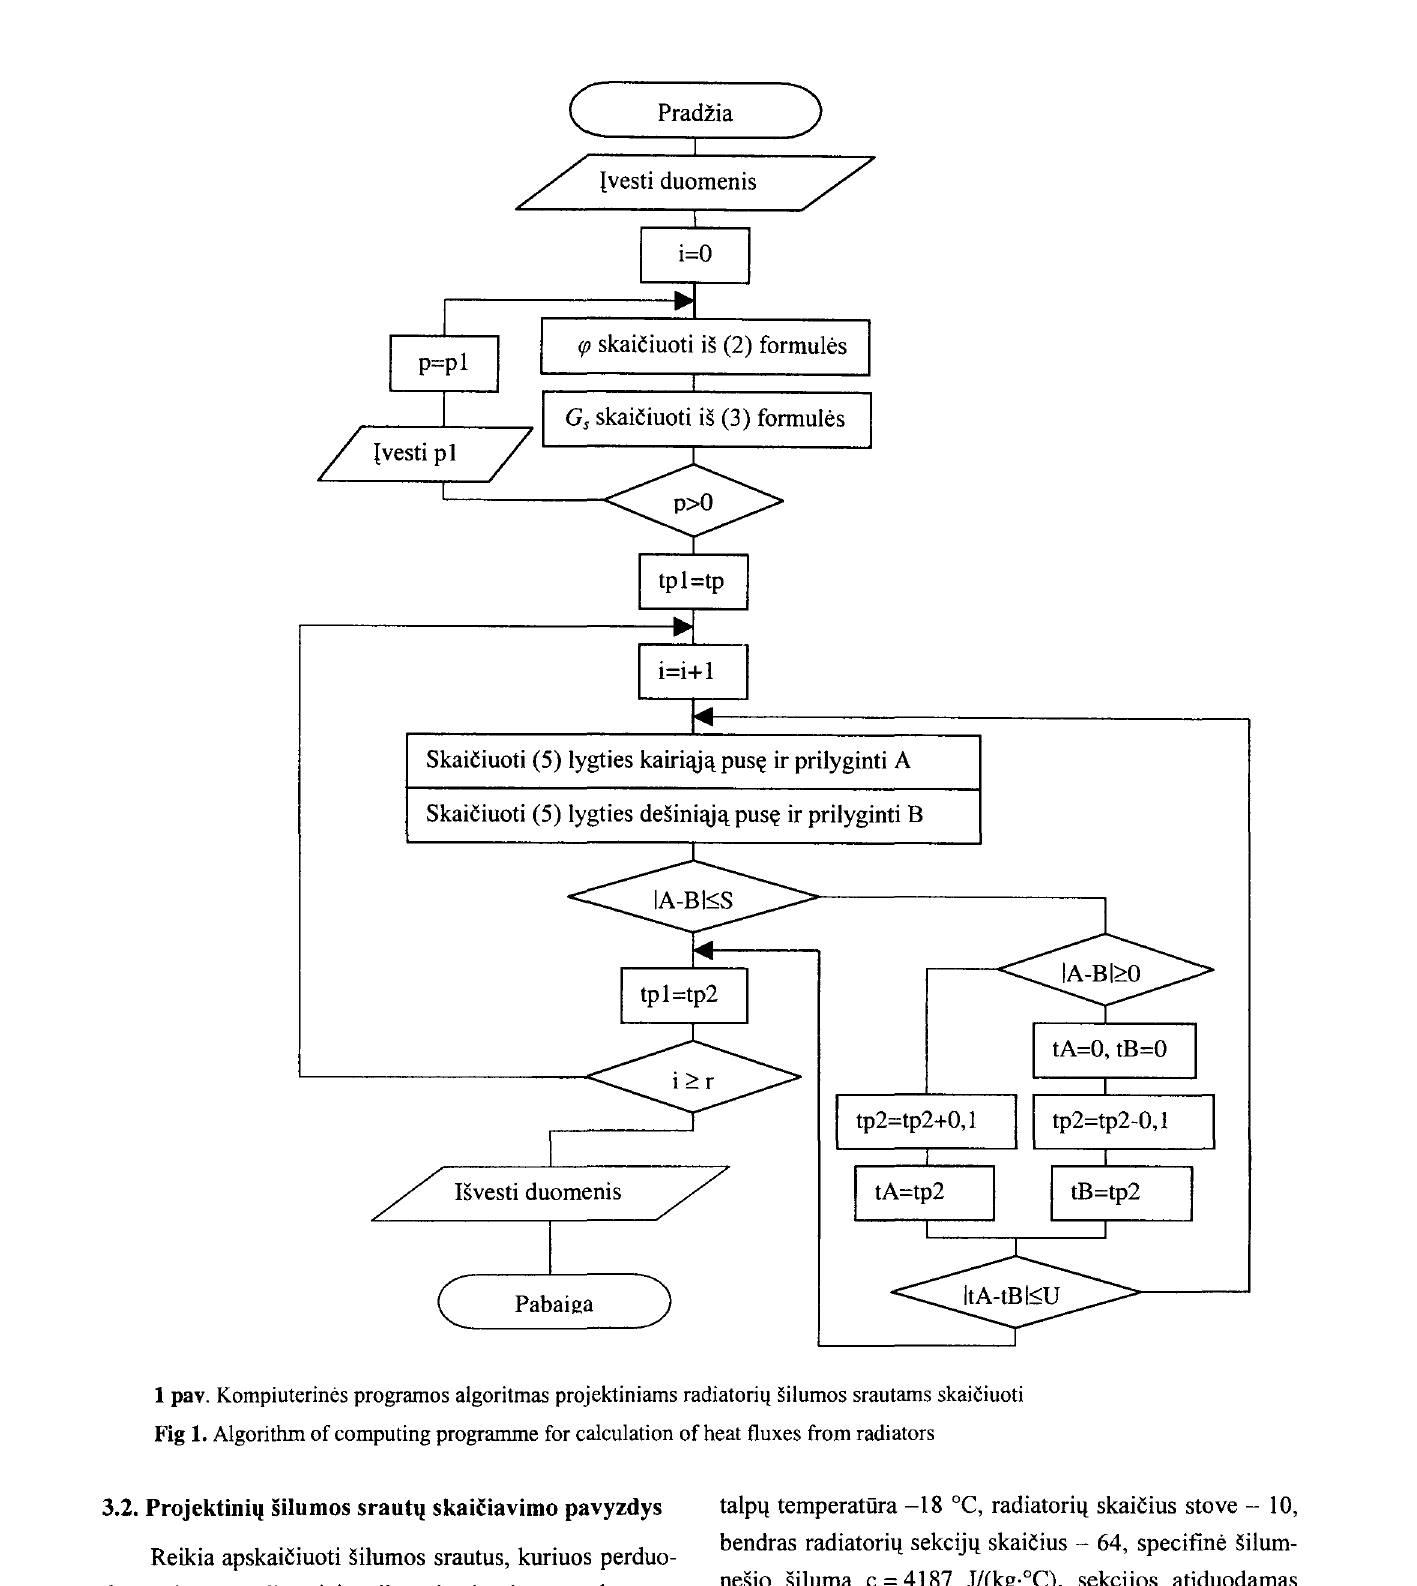
Fig 1. Algorithm of computing programme for calculation of heat fluxes from radiators 3.2. Projektiniq silumos srautq skaiciavimo pavyzdys Reikia apskaiciuoti silumos srautus, kuriuos perduo da patalpoms radiatoriai, prijungti prie vienvamzdes apa tinio paskirstymo sildymo sistemos stovo, kurio schema pateikta 2